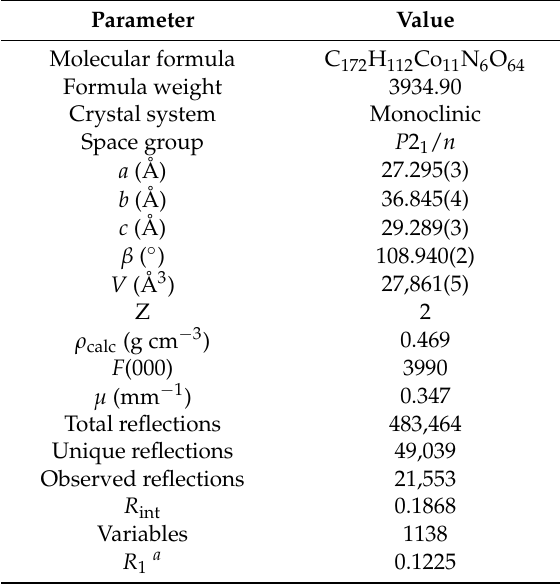
Figure 3. The structure of MOF 1 showing the Co 3 secondary building unit (SBU) supported by Co1 and Co2 viewing from two directions ( a , b ), the Co 2 SBU supported by Co3 and Co4 ( c ), the Co 2 SBU supported by Co5 and Co6 ( d ), the 3D network viewing along the [010] direction ( e ), and the 3D network viewing from the crystallographic a direction ( f ). All H atoms are omitted. For ( a – e ), only one of the disordered portion of the BTB ligand is depicted (H 3 BTB = 1,3,5-tris(4-carboxyphenyl)benzene), and for ( c , d ), only one disordered portion of the coordinated anion/solvent is depicted. Color legends: Co (magenta), O (red), N (blue), C (black). Table 1. Crystallographic data and refinement parameters for MOF 1